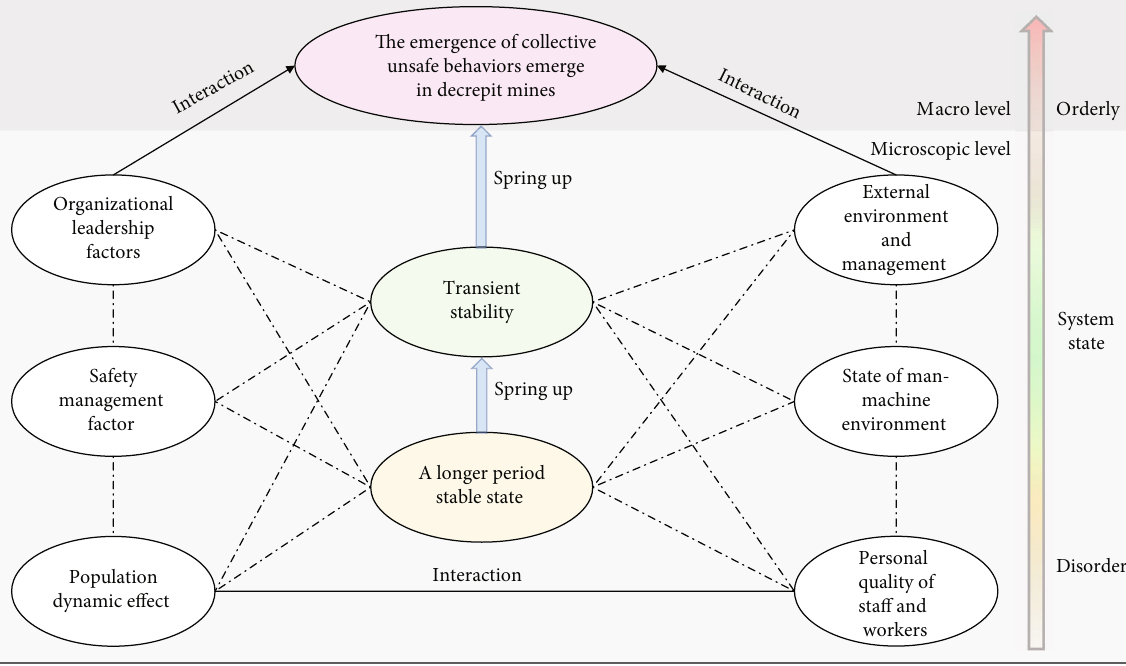
Figure 4: Schematic diagram of the emergence mechanism of unsafe behavior in aging pit